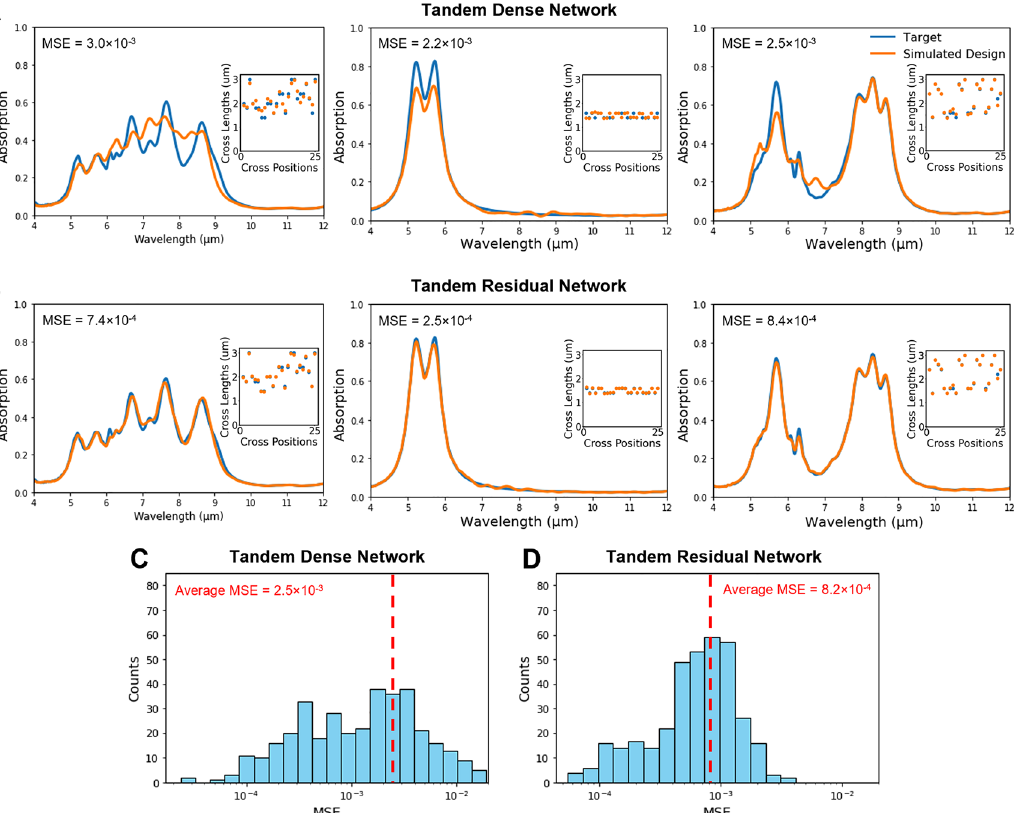
Figure 2: Performance evaluation based on mean-squared error (MSE) of target spectra and simulated designs for (A) the tandem dense and (B) tandem residual networks. The tandem residual network achieves a lower MSE for three distinct targets. Inset images show the design parameters for the corresponding spectra. Statistical analyses across the entire validation dataset (over 300 spectra) for the tandem dense (C) and residual (D) networks indicate that the latter achieves a lower average